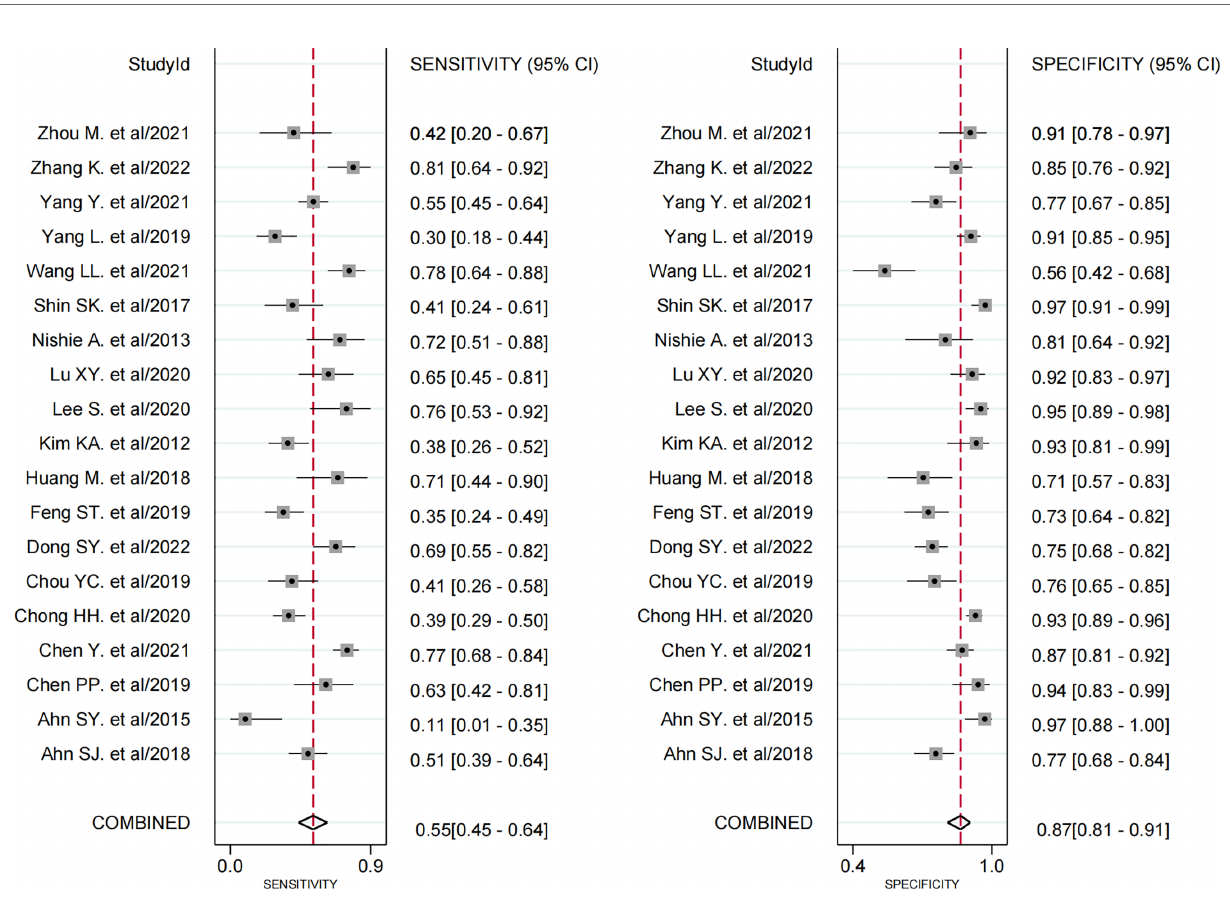
FIGURE 5 | Forest plots demonstrate the pooled sensitivity and speci fi city of peritumoral hypointensity on the hepatobiliary phase. The 95% CI are shown around point estimates and the pooled